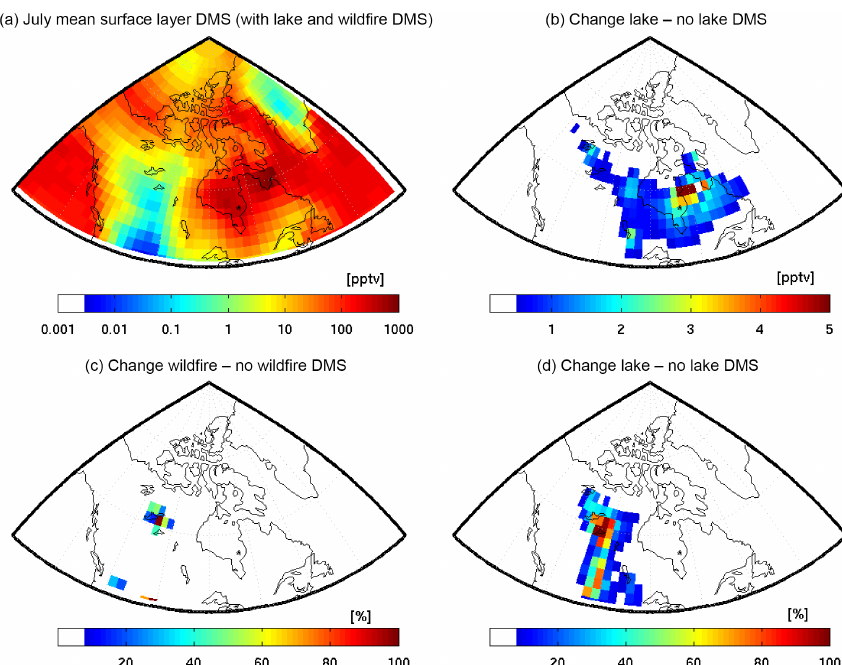
Figure 5. (a) GEOS-Chem simulated July mean surface-layer atmospheric DMS in Canada; (b) absolute change in simulated surface-layer DMS with implementation of lake DMS emissions; (c) percent change in simulated Canadian surface-layer DMS due to DMS emissions from wildfires; (d) percent changes in simulated surface-layer DMS with the implementation of lake DMS